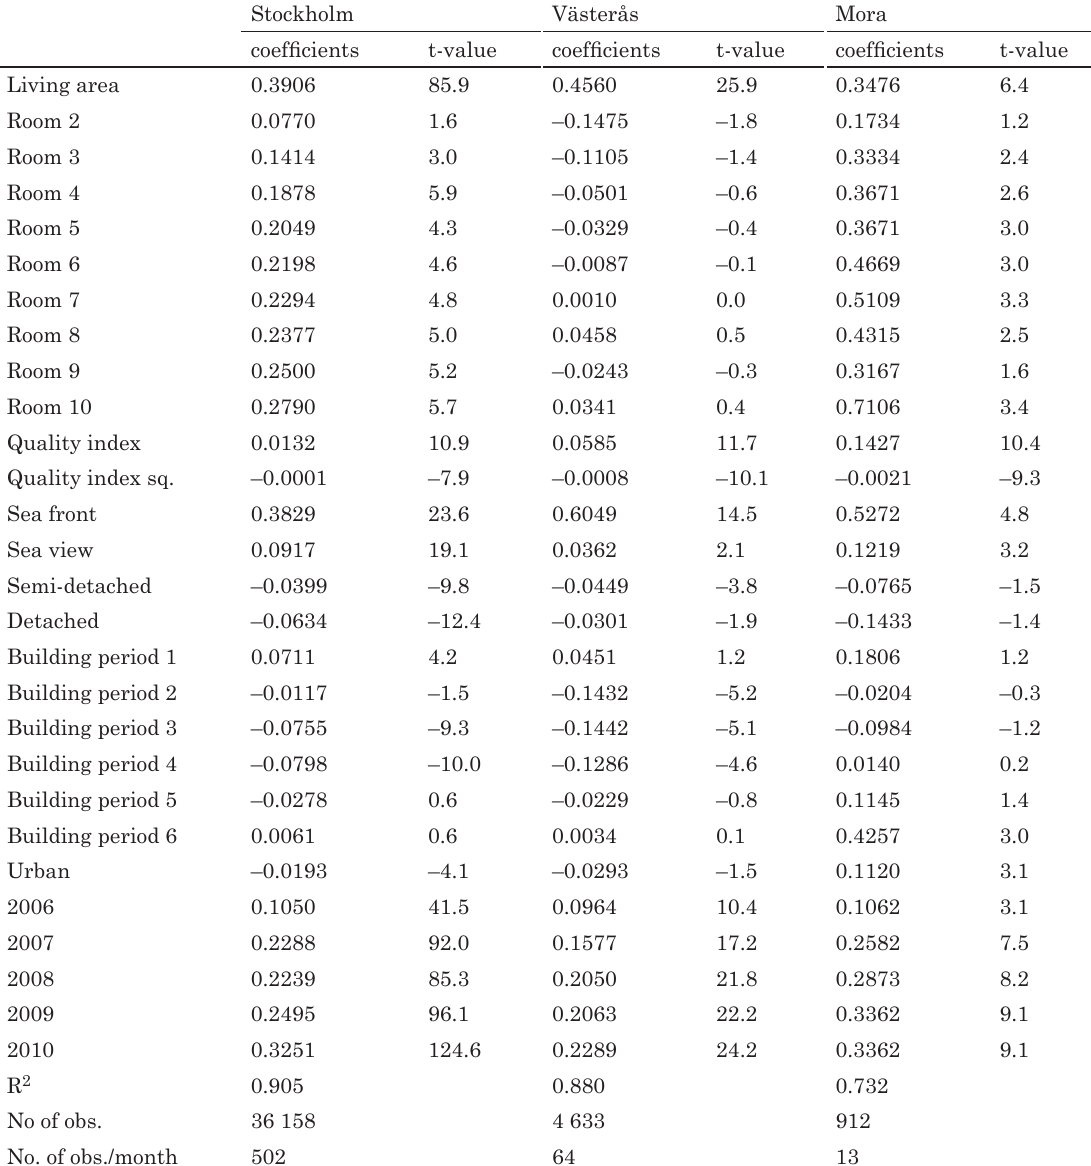
Table 3. Regression results (Labor markets of Stockholm, Västerås, and Mora)